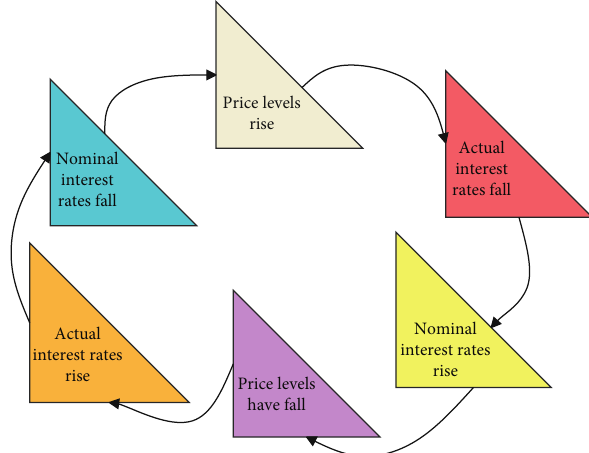
Figure 3: Interest rate fluctuation mechanism based on changes in price levels.